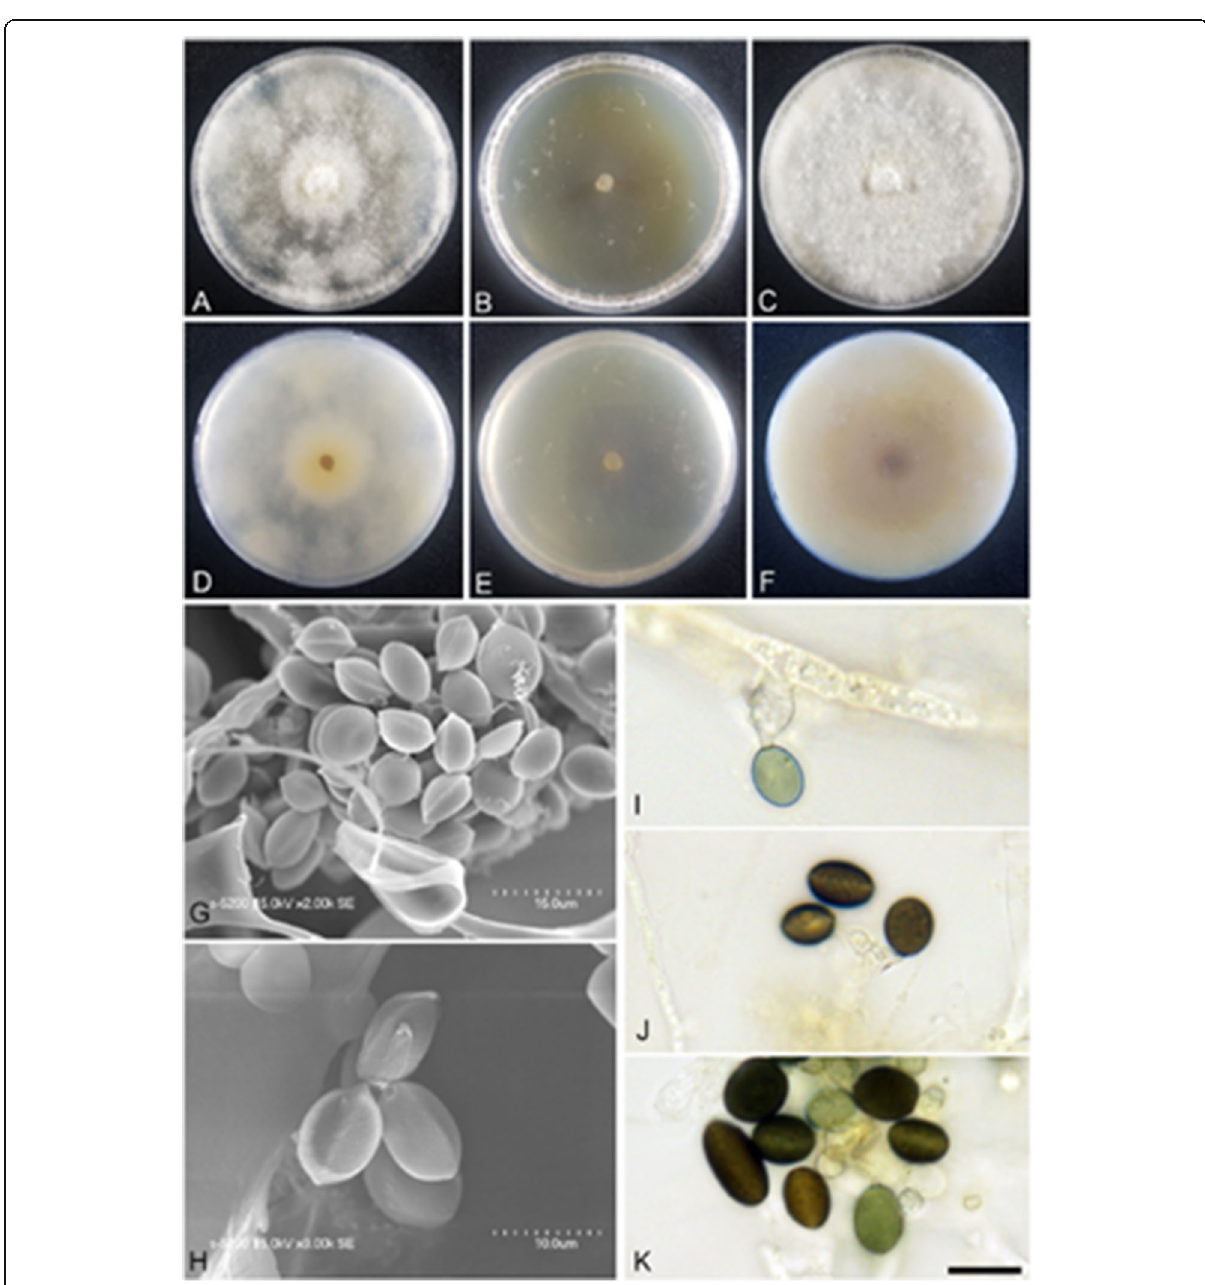
Fig. 7 Arthrinium marinum (KUC21328). a-c , Colonies on PDA ( a ), MEA ( b ), and OA ( c ) (top); d-f , colonies on PDA ( d ), MEA ( e ), and OA ( f ) (bottom); g- h , conidia under SEM; i-k conidia attached to conidiogenous cells; scale bar =10 μ